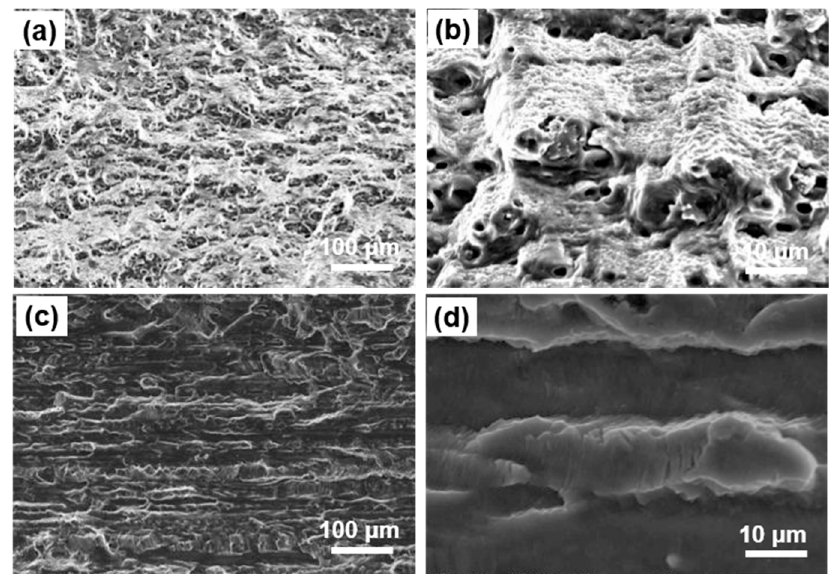
Figure 8. SEM fractography of Al-Cu-Li-Mg-Zr alloys upon a value of ∆ K at 20 MPa · m 1/2 . The mi- crographs collected at ( a , c ) a lower magnification and ( b , d ) a higher magnification for ( a , b ) High Fe and ( c , d ) Low Fe alloys.